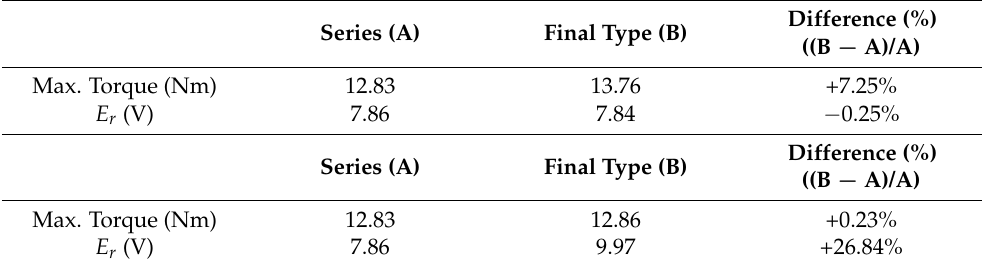
Table 6. Comparison of maximum torque and E r between final type and series type.